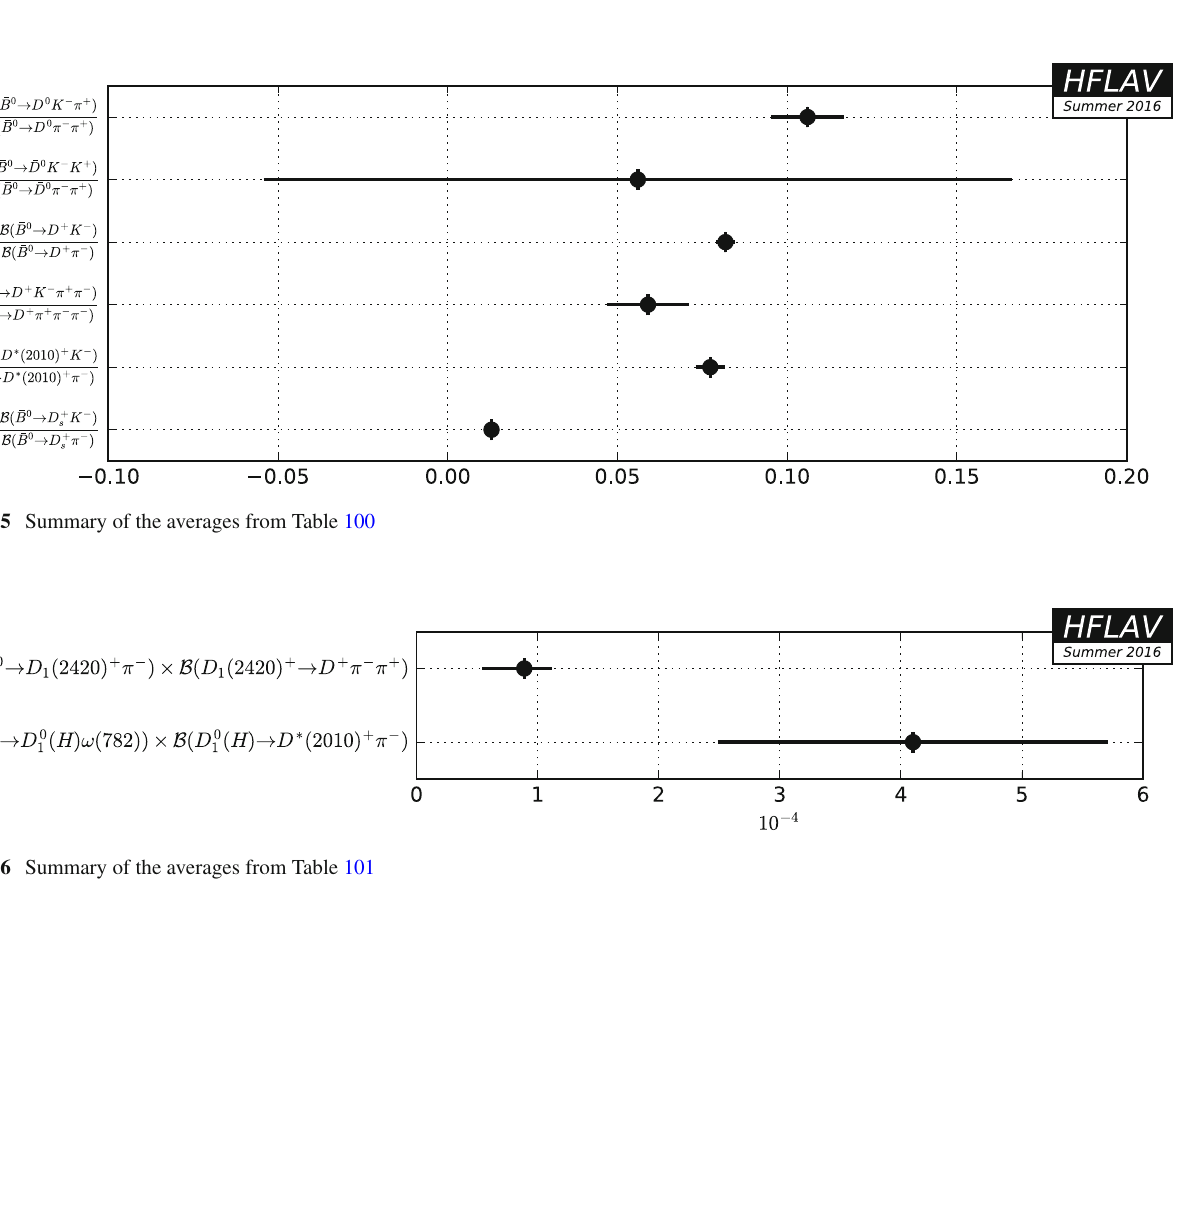
Fig. 74 Summary of the averages from Table 99